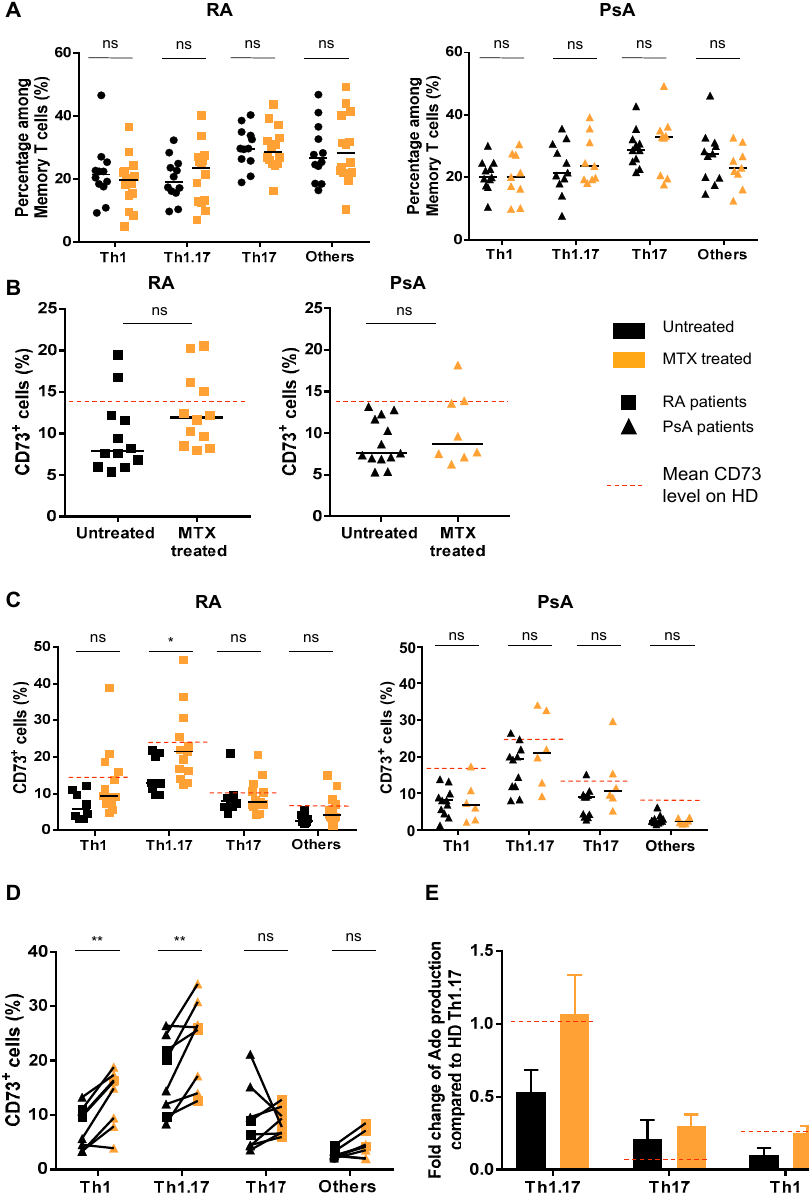
Figure 3. MTX treatment restores CD73 levels on Teff populations in RA patients but not in PsA patients. ( A ) Frequencies of Th subsets in peripheral blood of untreated versus MTX-treated RA (left) and PsA (right) patients. ( B ) CD73 percentages on total Teff in peripheral blood of untreated versus MTX treated RA (left) and PsA (right) patients. ( C ) CD73 percentages on Th subsets of untreated versus MTX-treated RA (up) and PsA (down) patients. ( D ) Paired samples showing CD73 percentages modulation in Th subsets upon MTX treatment in RA ( n = 4) and PsA ( n = 7) patients. ( E ) Fold change of Ado produced by sorted Th1.17, Th17 and Th1 subsets from untreated ( n = 3) and MTX-treated RA ( n = 3) patients. Cells were incubated for 2 h with AMP 13C15N isotope (37.5 µ M) +/ − APCP (50 µ M) before Ado quantification in supernatants by LC-MS/MS. Ado production was normalized to the production by Th1.17 from HD’s blood used as reference. A and C : ANOVA-2, B : Mann-Whitney test, D : ANOVA-2 with paired values. * p < 0.05, ** p < 0.001.